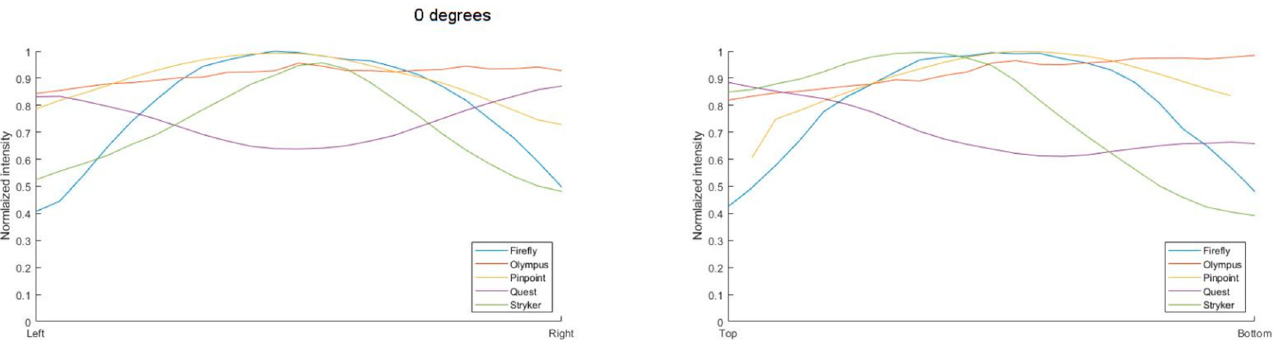
Figure 3. Four longitudinal cross-sections of the light distribution. On the y -axes, normalized intensity (maximum fluorescent intensity set at 100% and background noise at 0) is shown and on the x -axes the orientation of the phantom, which takes 13 cm from left to right. The top two images show the light distribution with the phantom placed at a zero degree.